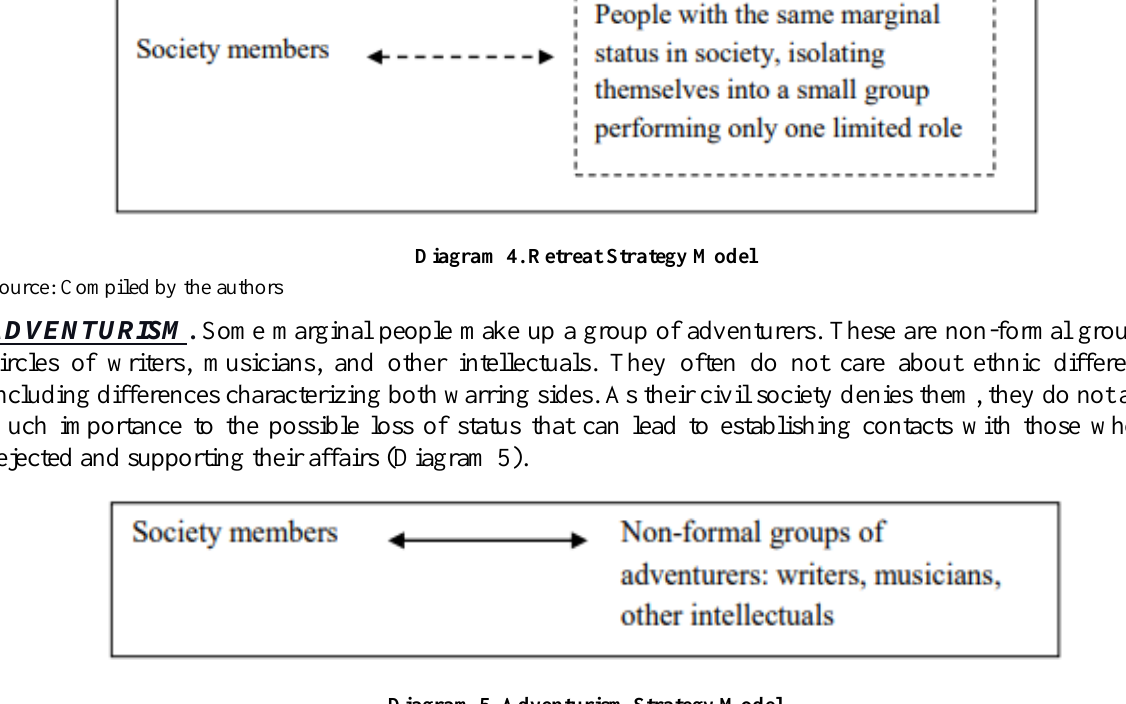
Diagram 5. Adventurism Strategy Model